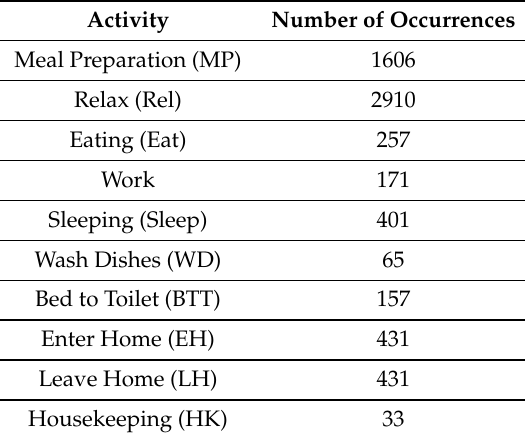
Table 4. Activities and Statistics of the Aruba